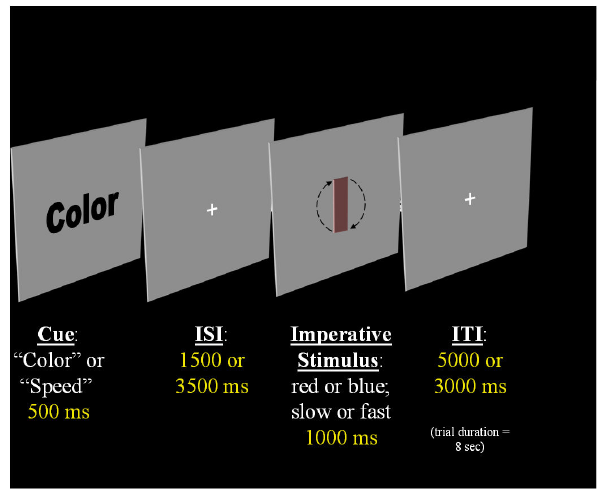
Figure 1. Task Switching Paradigm. Figure 1. shows an example of the task-switching paradigm performed in Experiment